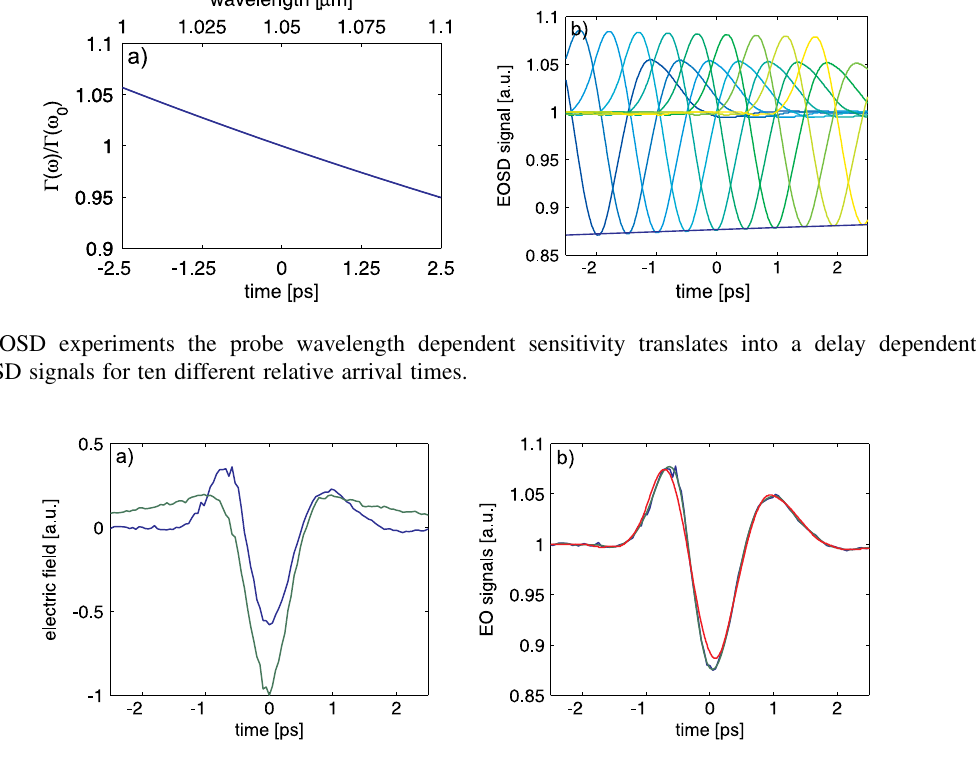
FIG. 9. (a) THz field emitted at turn 0 (green curve) in comparison to the expected electric field distribution after the beam transfer line (blue curve). (b) The corresponding simulated EOS (green curve) and EOSD (red curve)